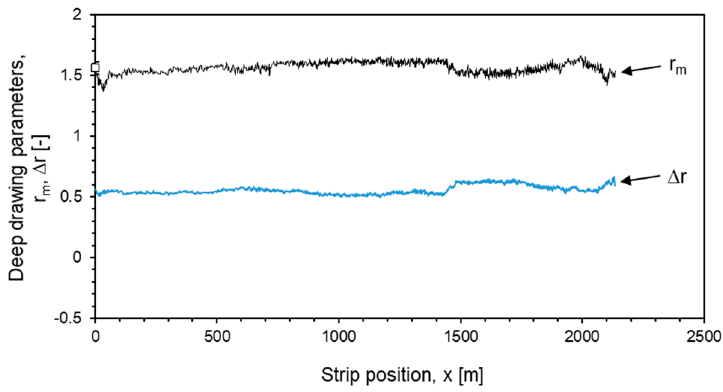
Figure 8. Inline measurement of vertical anisotropy r m and planar anisotropy ∆ r in a coil of 2300 m in length.